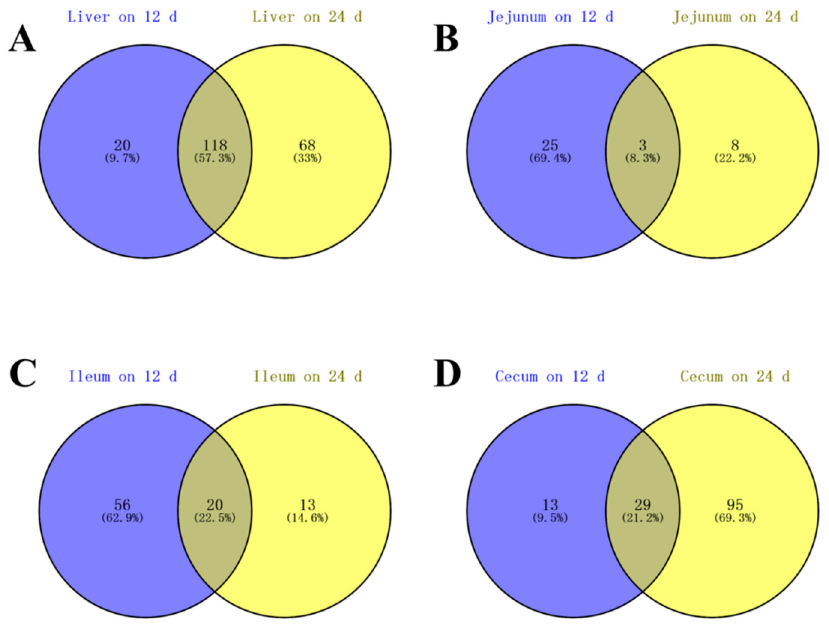
Figure 2. Venn diagram of differential metabolites in the liver, jejunal, ileal, and cecal contents of the overfed vs. control geese on day 12 (12 d) and day 24 (24 d) of overfeeding. The figures represent the analysis of liver ( A ), jejunal ( B ), ileal ( C ), and cecal contents ( D ), respectively.